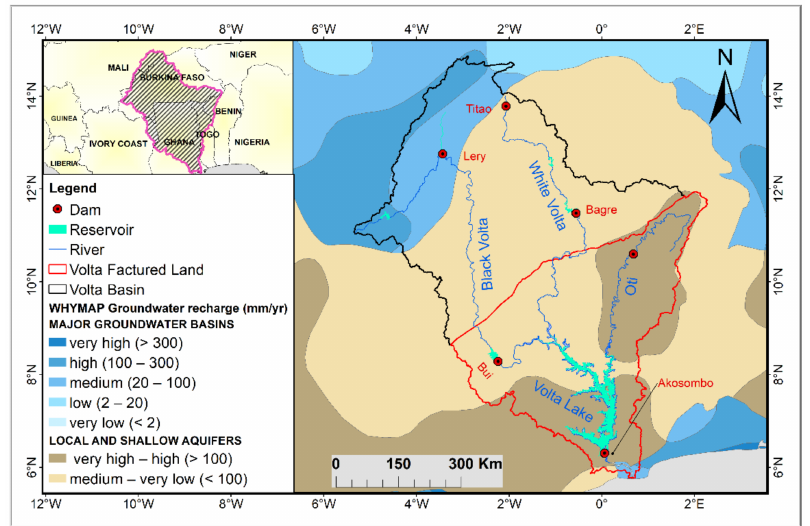
Figure 1. Study area showing the Volta River Basin and its river system (Black Volta, White Volta, and Oti River). The shaded region in the inset map is the extent of the Volta River